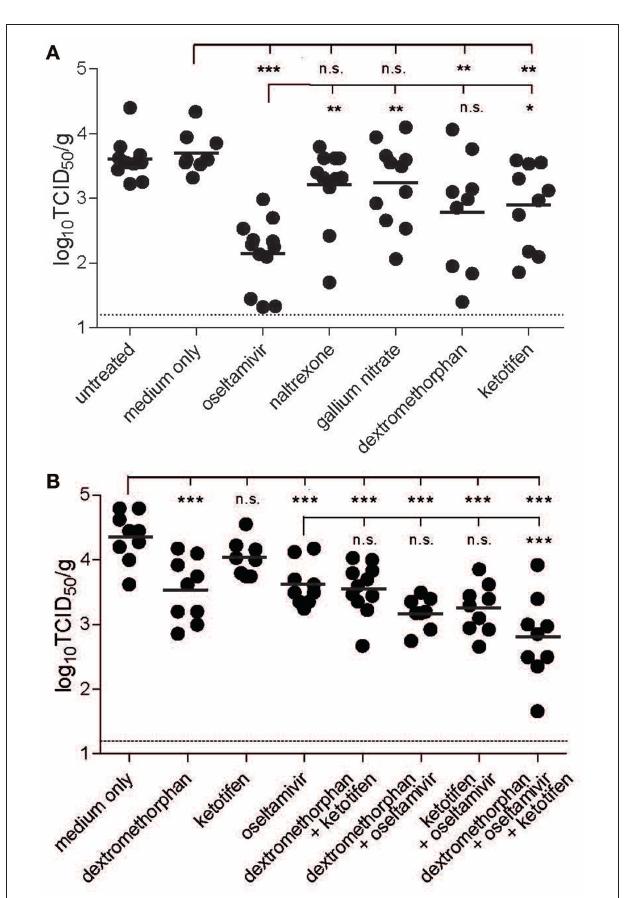
FIGURE 3 | Inhibitory effect of drug candidates in mice. C57BL/6 mice were treated orally once daily starting 1 day before infection and continuing until sacrifice with the respective drug at the maximum tolerated dose individually (A) or in combination (B) . The animals were infected intranasally with 10 3 TCID 50 of PR8. Three days post-infection, the animals were sacrificed and the lung titers were quantified by limited dilution method and expressed as TCID 50 /g tissue. Bars indicate group means, and the dotted line reflects the detection limit of the assay. One-way analysis of variance (ANOVA) with Dunnett’s Multiple Comparison Test was used for statistical analyses (no significance (n.s.), * p < 0.05, ** p < 0.01, *** p < 0.001).